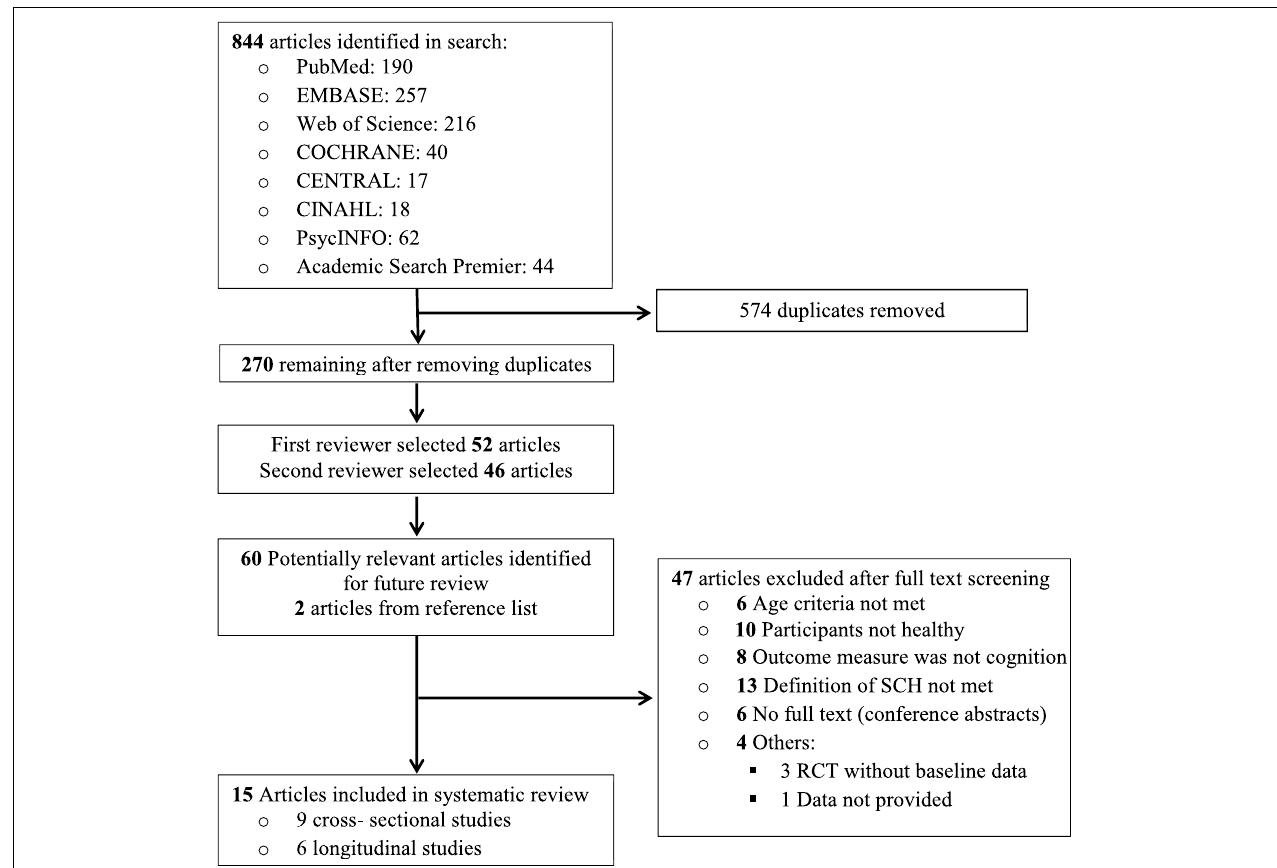
FIGURE 1 | Flowchart showing the literature search for the systematic